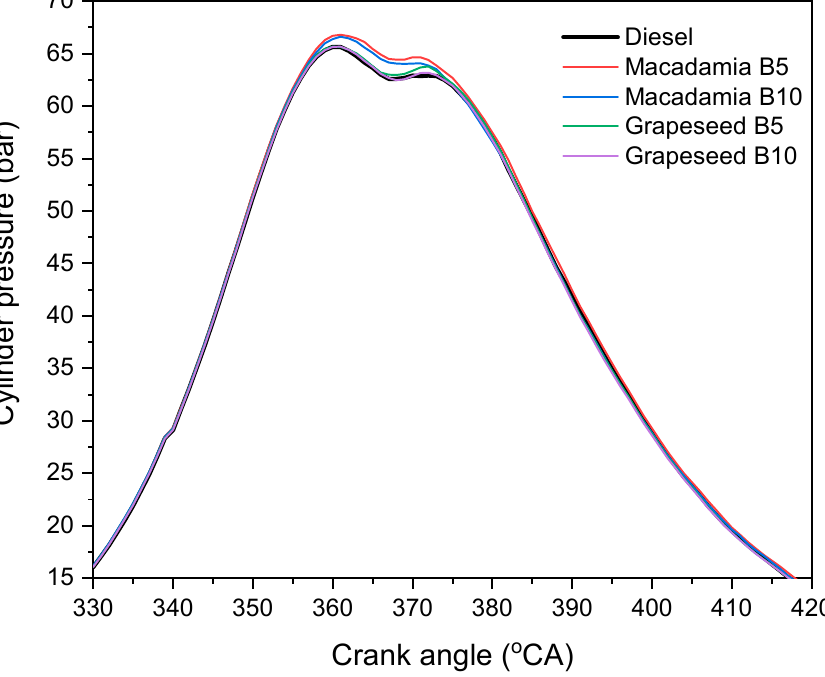
Figure 10. Variation of cylinder pressure with the crank angle at full engine load condition.